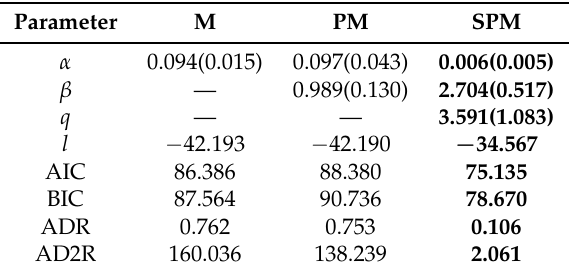
Table 9. ML estimates for the copper data with standard deviations in parentheses.